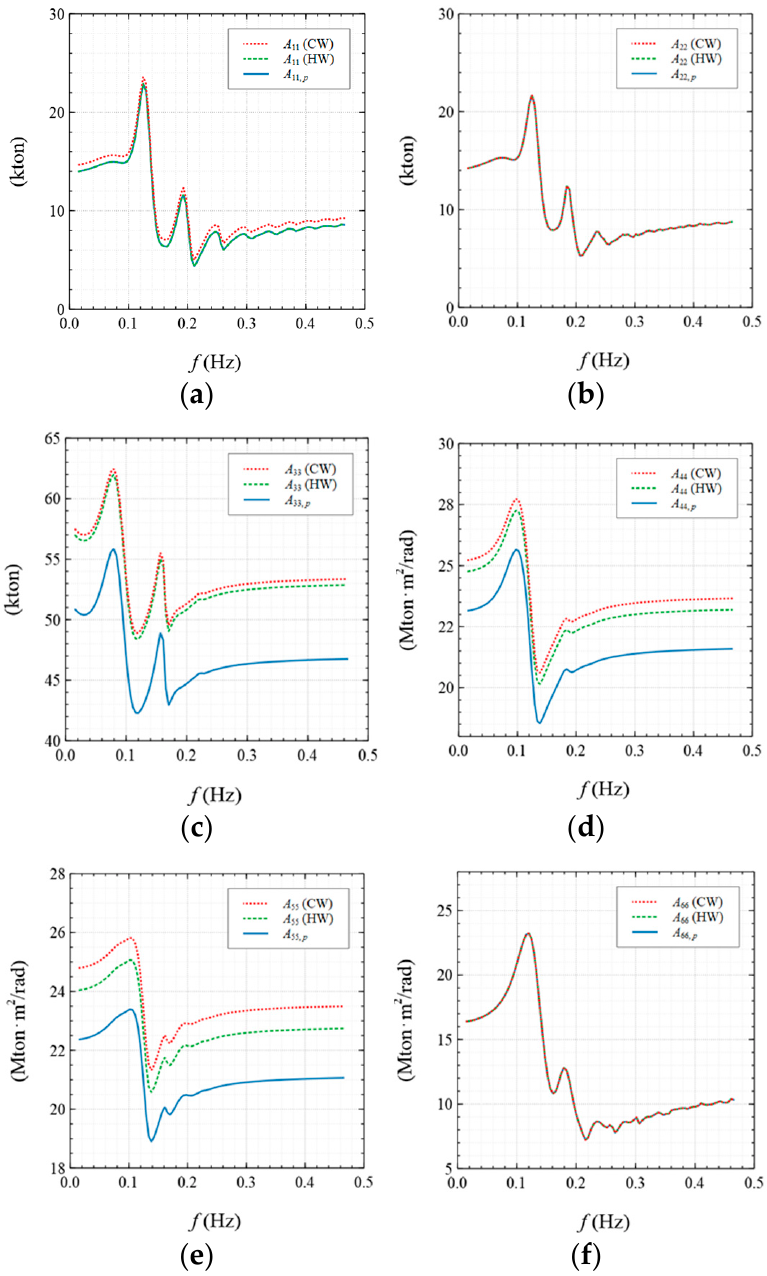
Figure 11. Comparison of added masses in different motion directions: ( a ) surge; ( b ) sway; ( c )